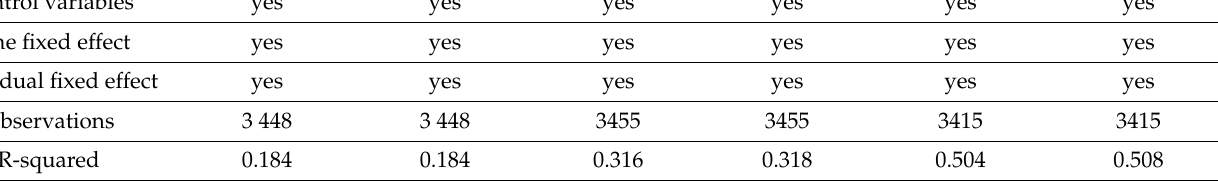
Figure 8. Placebo test.